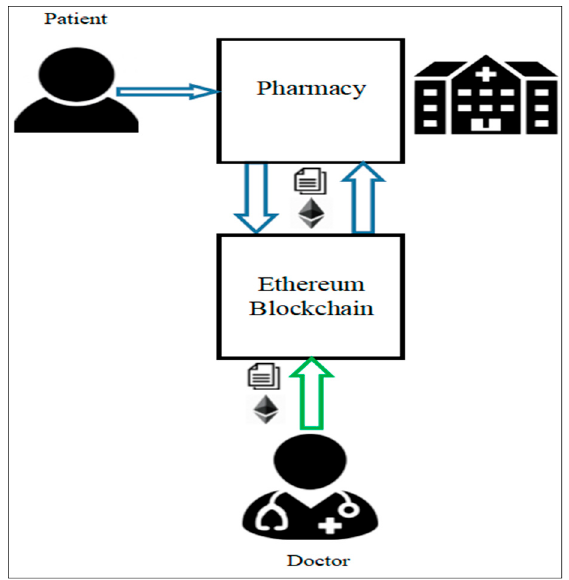
Figure 3. Smart contract for issuing and filing of medical prescriptions.